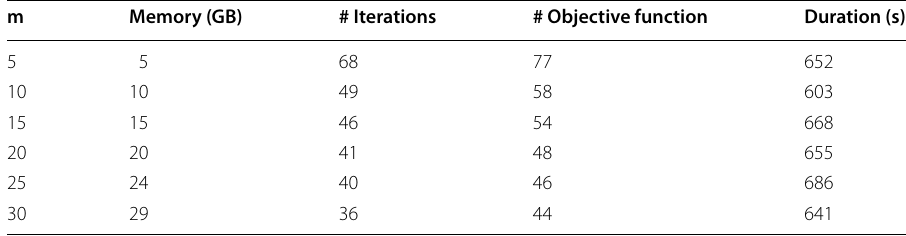
Table 2 Results description for lshtc‑small dataset